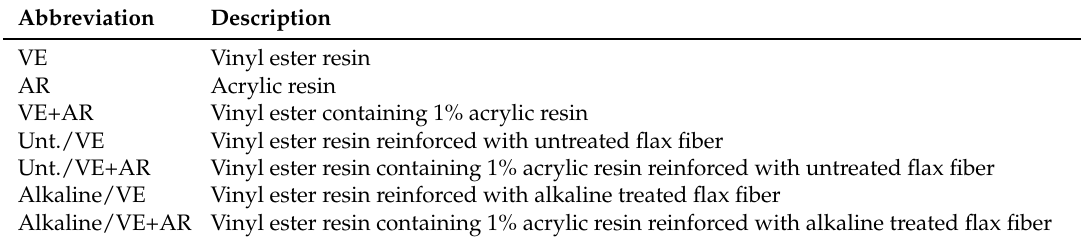
Table 2. Abbreviations used to describe different composites and specimens used in this study.